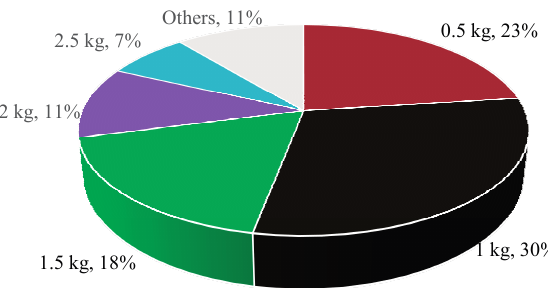
Figure 3. Distribution of the quantity of household kitchen waste on average per day during the last week ( n = 394).